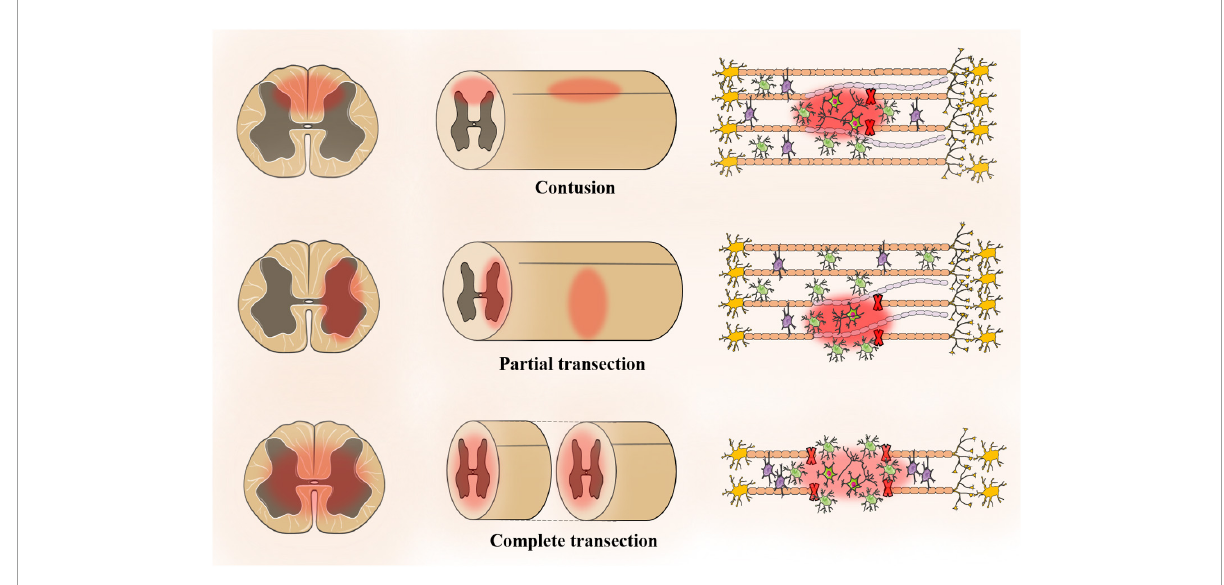
FIGURE2 The animal model for spinal cord injury